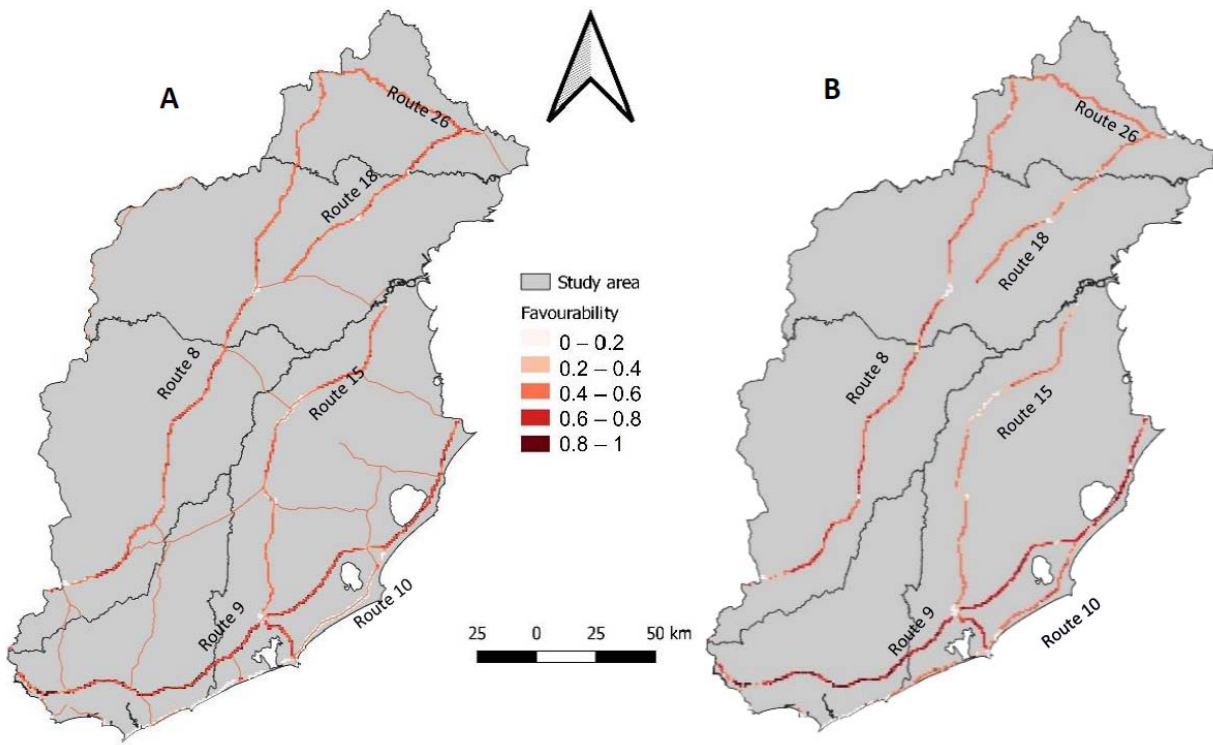
Figure 3. Models obtained for native forest species. ( A ) Model with the 3 factors (climatic, geographic, and anthropic), ( B ) Model with the anthropic factor.